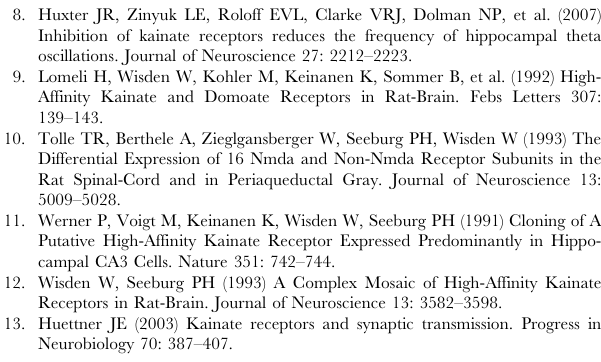
Figure S1 Kainate (KA) induced changes in whole-cell holding current of KARs on LII mEC stellate neurons. (A) Electrophys- iological and morphological properties of a typical LII mEC stellate neuron. (B) Upon application of 300 nM KA, LII stellate neurons (n= 7) depolarised to a significantly lesser degree as compared to LIII pyramidal neurons (p , 0.01; n= 4). (C) Time course data from a single experiment of the whole-cell holding current of a LII stellate neuron upon bath application of 300 nM of KA in the presence of GYKI (20 m M). Found at: doi:10.1371/journal.pone.0005576.s001 (0.63 MB